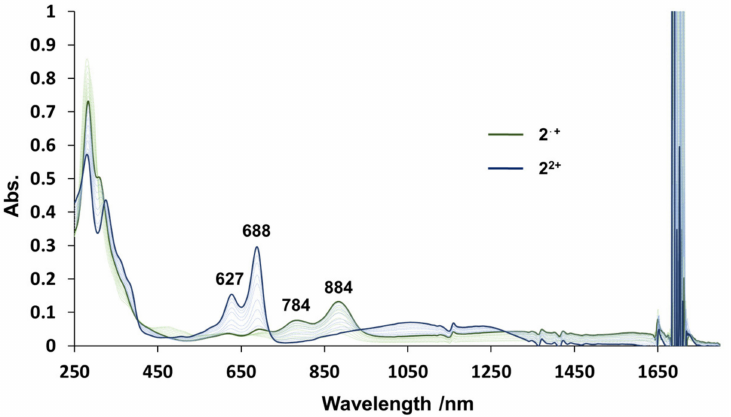
Figure 5. Stepwise oxidation of DEHPHAC 2a with SbCl 5 in CH 2 Cl 2 ([2] = 6.79 × 10 − 6